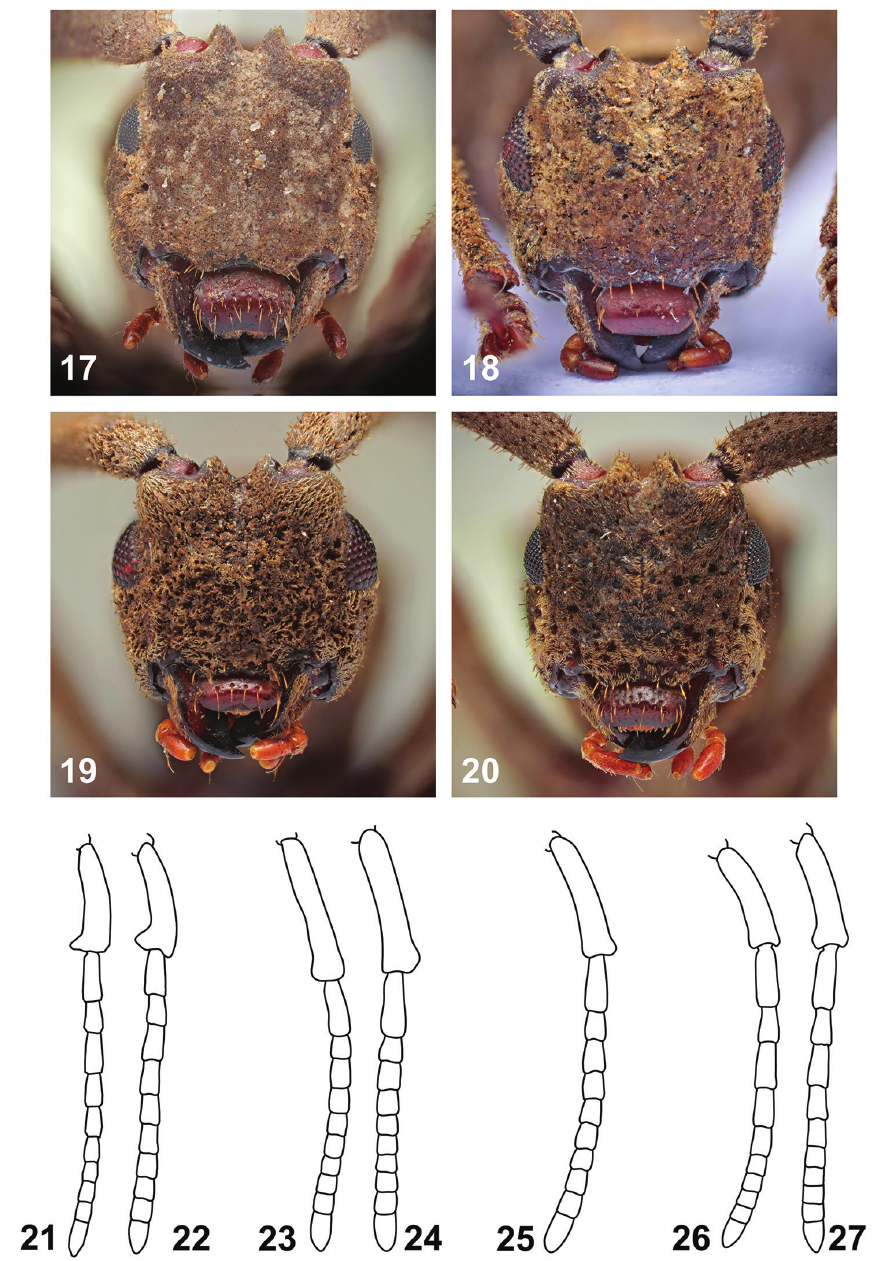
Figures 17–27. Anexodus spp.: 17–20 Head, frontal view: 17 Anexodus aquilus Pascoe, holotype male 18 Anexodus sarawakensis Sudre, holotype male 19 Anexodus syptakovae sp. n., holotype male 20 Anexodus tufi sp. n., holotype male 21–27 Antenna: 21 Anexodus aquilus Pascoe, male 22 Anexodus aquilus Pascoe, female 23 Anexodus sarawakensis Sudre, male 24 Anexodus sarawakensis Sudre, female 25 Anexodus sypta- kovae sp. n., male 26 Anexodus tufi sp. n., male 27 Anexodus tufi sp. n., female. Not to